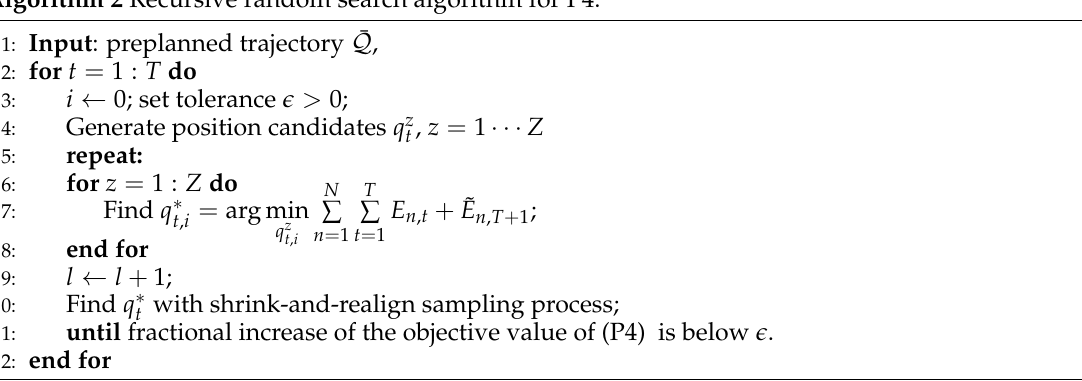
Algorithm 2 Recursive random search algorithm for